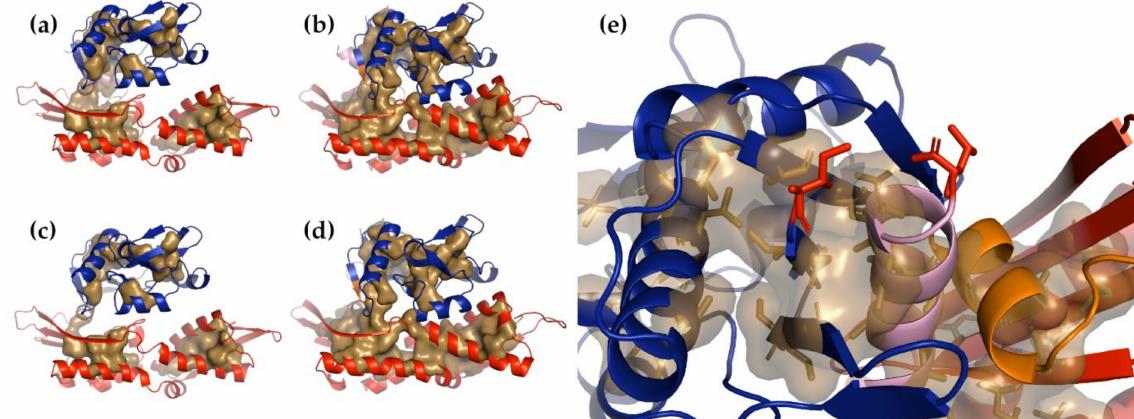
Figure 3. The Apo and Holo forms of the Hsp70 NBD. In all panels, lobe I is blue, lobe II is red, the C-terminal α -helix is pink, and the linker between the two domains is yellow. The sand-colored surface inside each molecule shows the residues buried in the domain core. ( a ) The intact Apo form, ( b ) the intact Holo form, ( c ) the tailless Apo form, and ( d ) the tailless Holo form. Note that loss of the C-terminal α -helix broke the density between the two domains, and NMA showed that lobe I and lobe II became more flexible with respect to one another. ( e ) The region of the NBD Apo form containing both the N- and C-terminal residues (as sticks, colored red). A careful examination suggests that applying force in opposite directions to the red-colored residues will result in the extraction of the C-terminal α -helix (pink). The Apo form is from PDB structure 2KHO [51] and the Holo form is from PDB structure 4B9Q